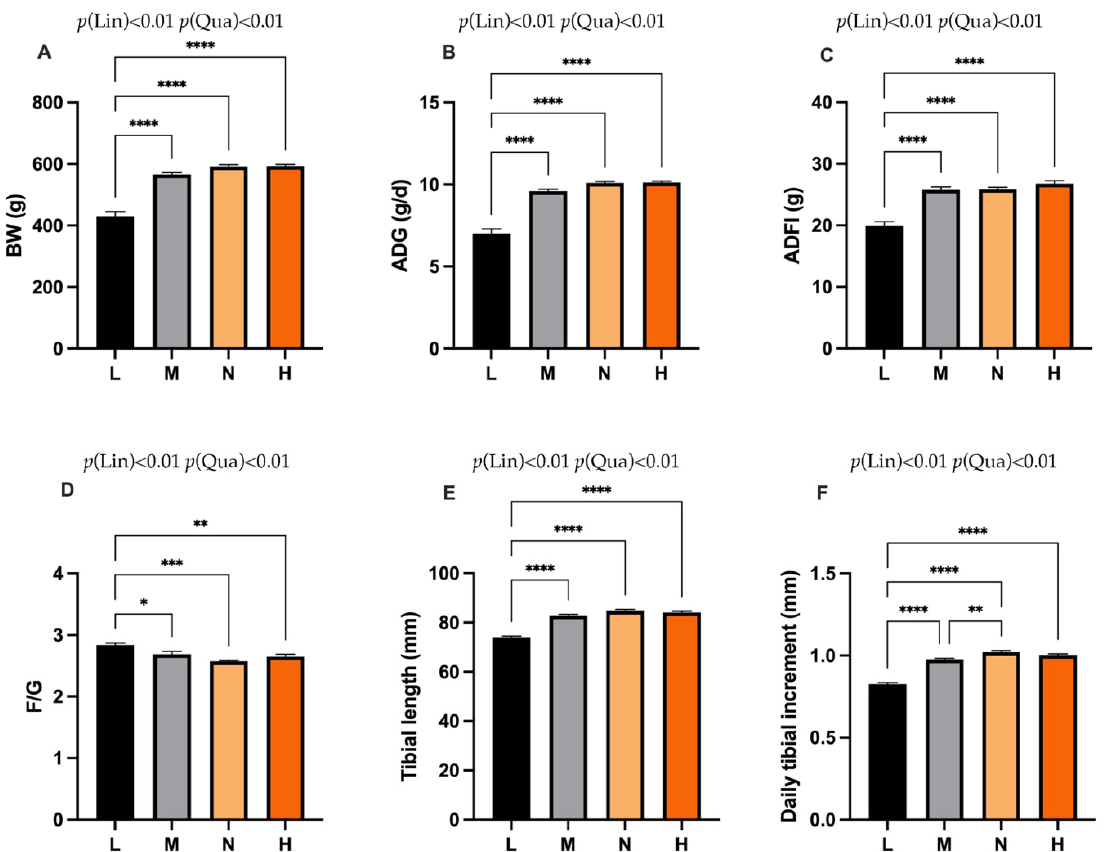
Figure 1. Effects of phosphorus restriction on growth performance of layers at 8 weeks of age. ( A ) BW ( B ) ADG ( C ) ADFI ( D ) F/G ( E ) Tibial length ( F ) Daily tibial increment. BW = body weight, ADG = average daily gain; ADFI = average daily feed intake; F/G = the ratio of feed to gain. Data are shown as mean ± SEM. * p < 0.05, ** p < 0.01, *** p < 0.001, **** p < 0.0001, P(Lin) = p -value (linear effect), p (Qua) = p -value (quadratic effect). L = group fed 0.13% nPP; M = group contained 0.29% nPP; N = group contained 0.45% nPP; H = group contained 0.59% nPP. n = 6 per group.